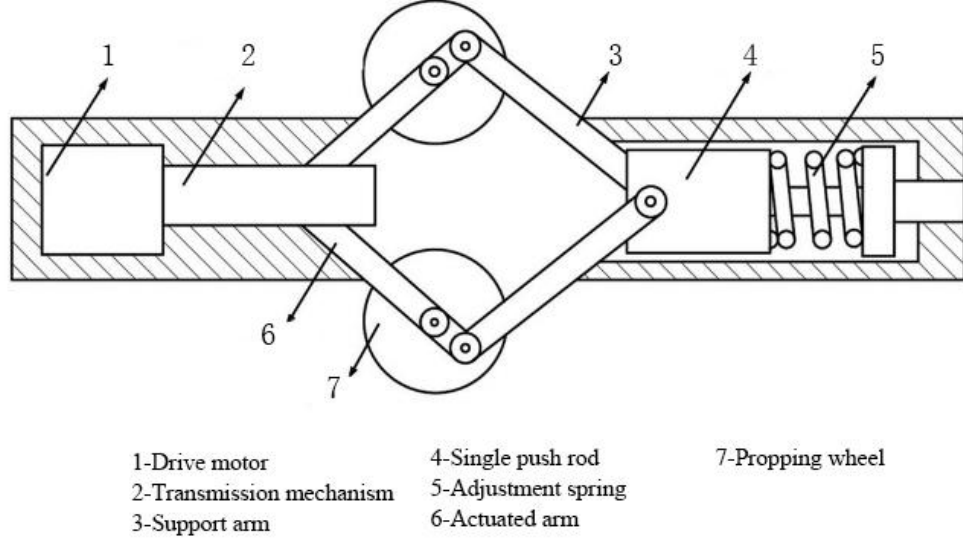
Figure 2. Structures of single push rod support adjustment